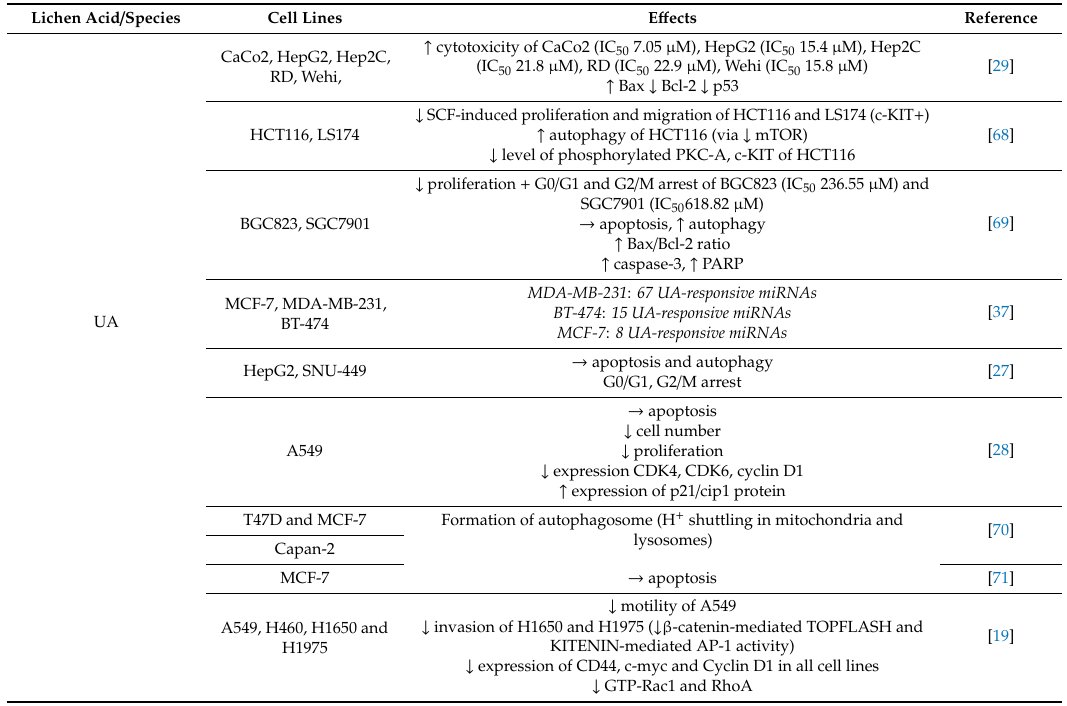
Table 2. Anticancer potential of isolated lichen